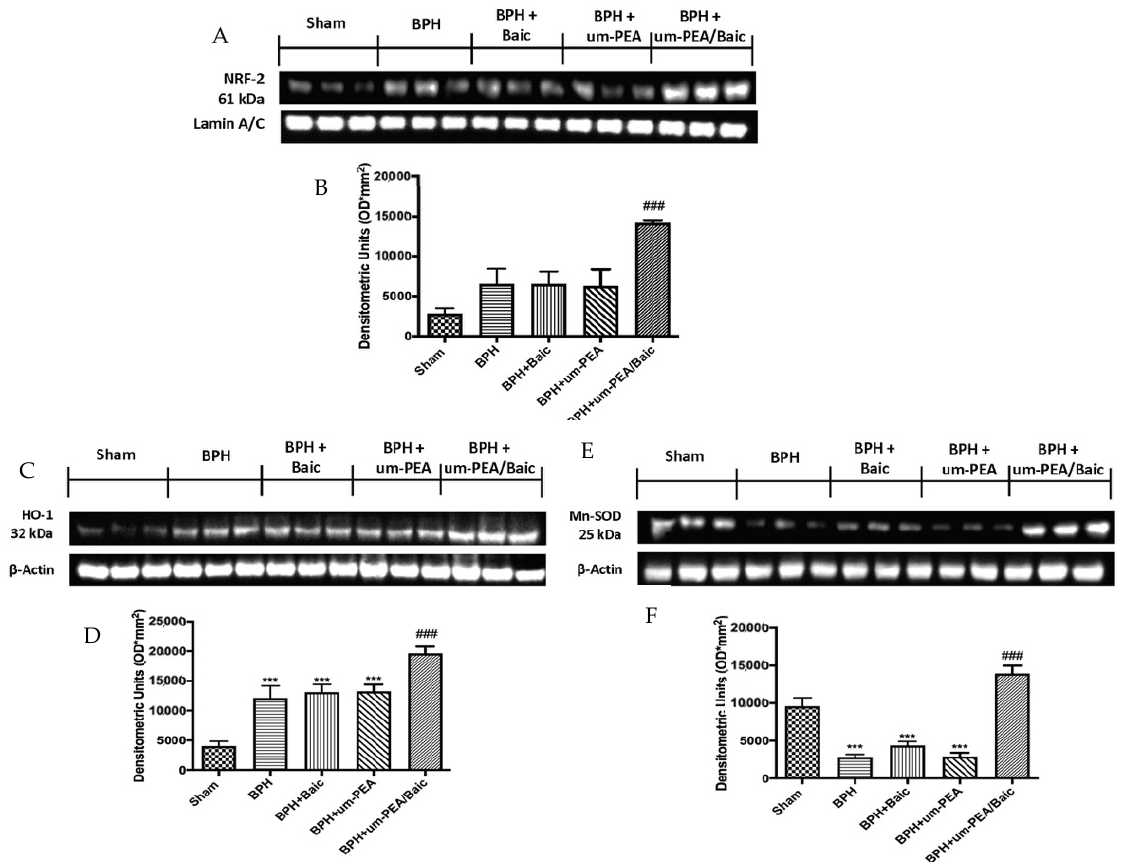
Figure 6. Effect of um-PEA/Baic on oxidative stress. Western blots and densitometric analysis of Nrf-2 ( A , B ), HO-1 ( C , D ) and Mn-SOD ( E , F ). A demonstrative blot of lysates with a densitometric analysis for all animals is shown. Values shown are means ± SEM of six animals in each group. *** p < 0.001 vs. sham; ### p < 0.001 vs. BPH group.